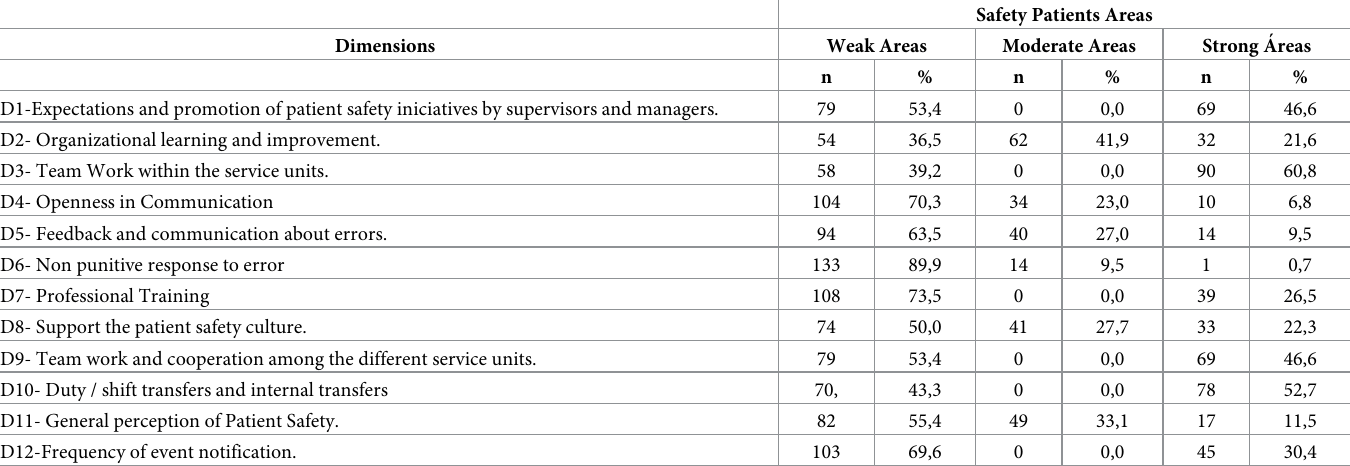
Table 4. Patient safety dimensions. Ceara´, Brazil, 2018.